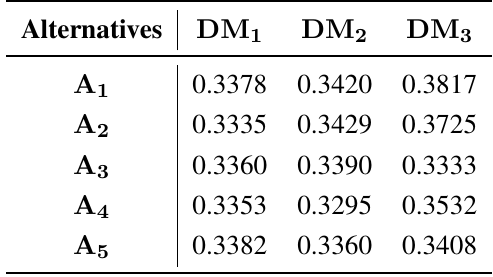
Table 4. Score matrix of alternatives by each expert.